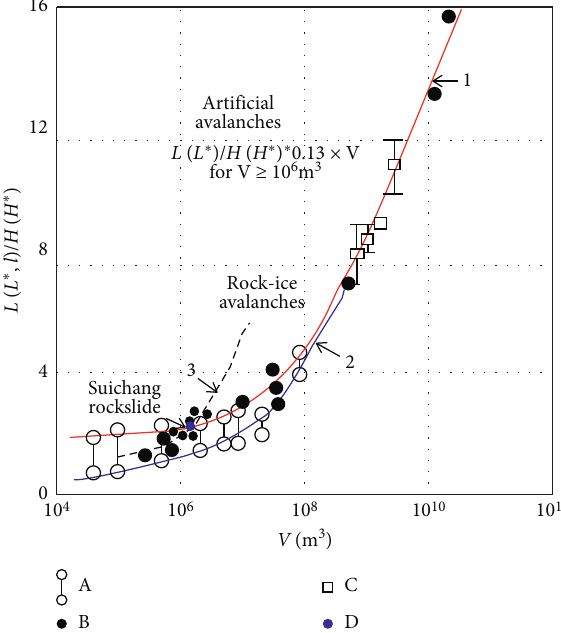
Figure 11: Relationship between the length to fall height ratio and volume of the rockslide (after Xu, modified, 2010): A, rockslide induced by earthquake or explosions. The upper curve represents the ratio of L ∗ / H ∗ , and the lower curve represents the ratio of l / H ∗ ; B, rock-ice avalanches in the Khibini Mountains; C, volcanic rock avalanches; D, natural nonvolcanic rock